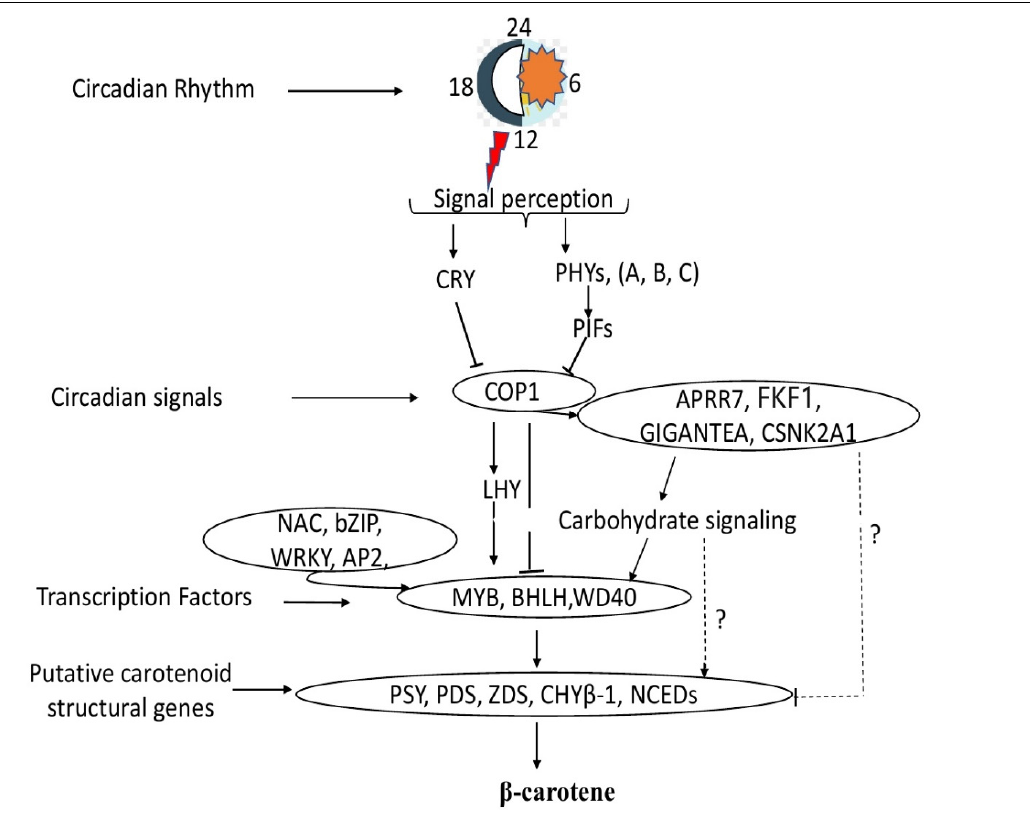
Figure 10. Schematic overview of the proposed model for photoperiod-induced β -carotene accumu- lation in the endocarp of XIS cucumber fruit. Arrows represent activation while T-bars represent repression. The gene names were the same as described in the main text. The question mark (?) de- notes unknown molecular mechanisms involved between light signaling genes, carbohydrate-related genes, and putative carotenoid pathway